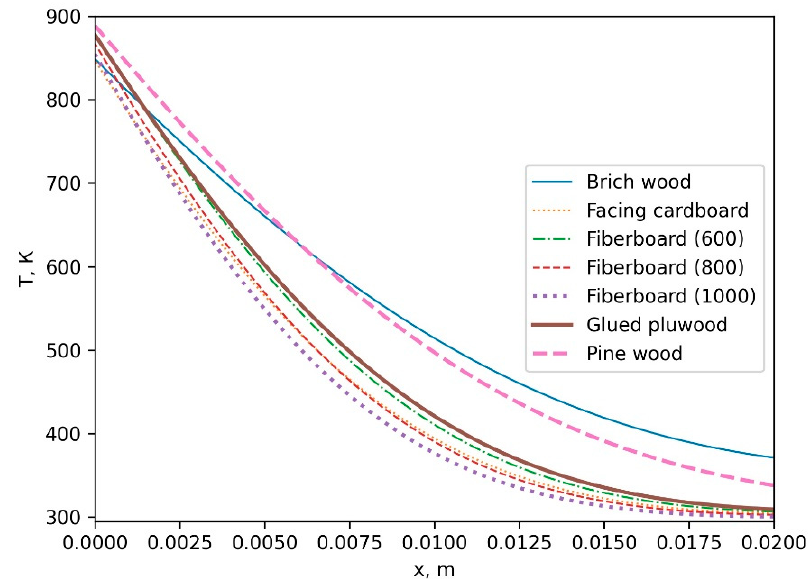
Figure 13. Impact of surface forest fires (low intensity) on various materials from a distance of 20 m in 425 s of exposure—temperature distribution over the wall thickness.